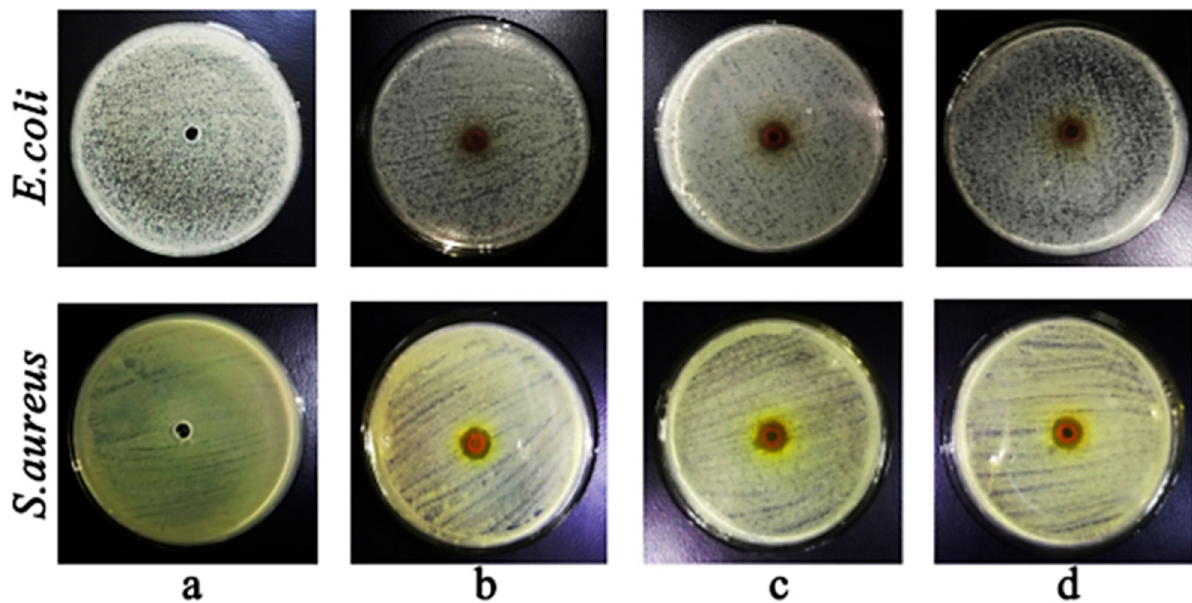
Figure 4. Antibacterial ring test of different HA-modified pullulan polymers, three curcumin-grafted and one not grafted (( a ) HA-SPu, ( b ) Cur-HA-SPu I, ( c ) Cur-HA-SPu II, ( d ) Cur-HA-SPu III). The antimicrobial activity of Cur-HA-SPu on gram-positive bacteria is better than that of gram-negative bacteria. Reprinted from [37]. Copyright 2020, with permission from Elsevier.